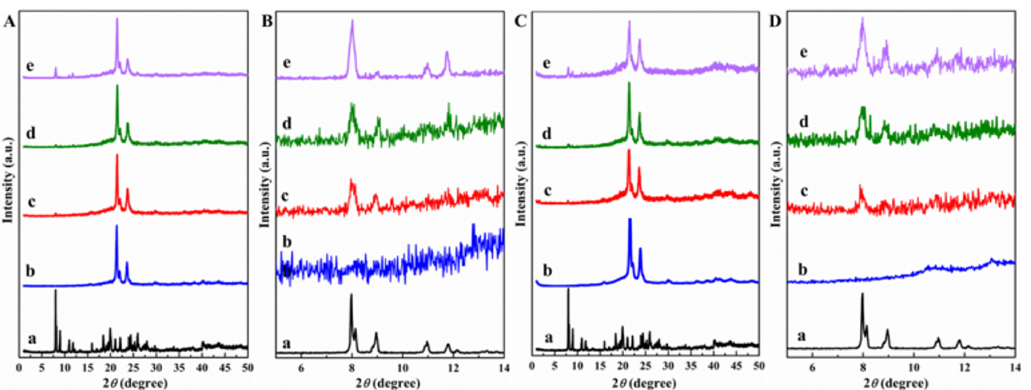
Figure 2. XRD patterns ( A , B ) solution blended, ( C , D ) melt mixed: ( a ) aminopropylheptaisobutyl-POSS (APIBPOSS), ( b ) Polycaprolactone (PCL), ( c ) PCL/APIBPOSS-2, ( d ) PCL/APIBPOSS-5, ( e ) PCL/APIBPOSS-10; ( B , D ): enlarged XRD patterns in the 2 θ range 5–14